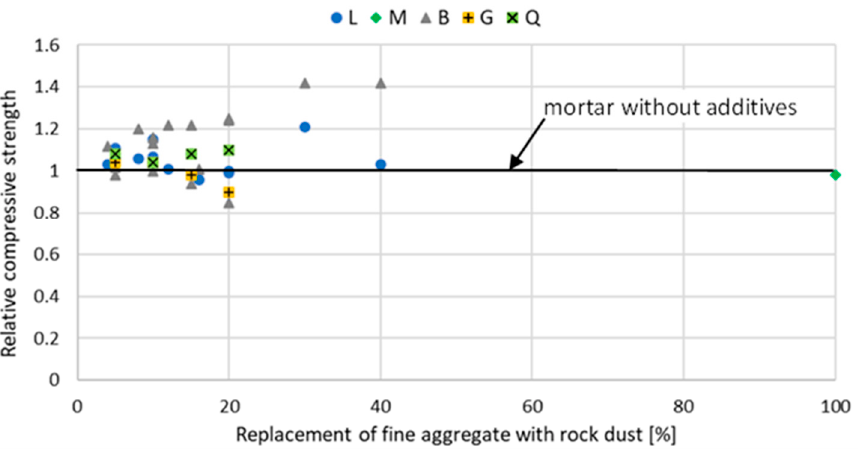
Figure 3. The effect of replacing fine aggregate with rock dust on the compressive strength of mortar after 28 days of curing: limestone dust (L) [46,55,95,97], marble dust (M) [63,67,76,86], basalt dust (B) [46,55,57,96], granite dust (G) [95], quartz dust (Q) [95].